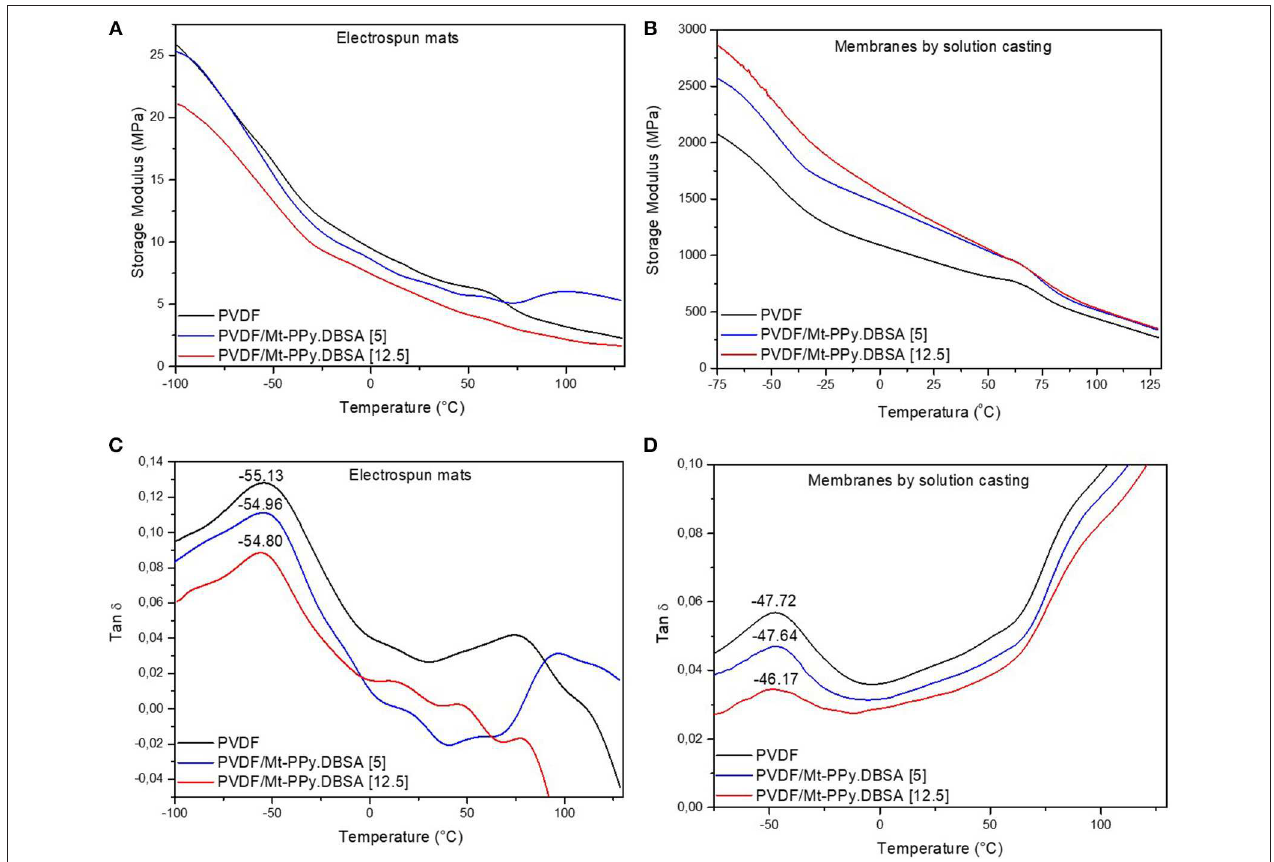
FIGURE 4 | DMTA traces (A,B) storage modulus and loss factor (C,D) of electrospun mats and membranes fabricated by solution